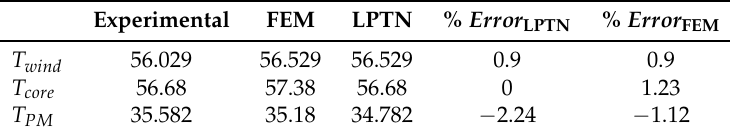
Table 4. Steady state temperatures at 1000 rpm.